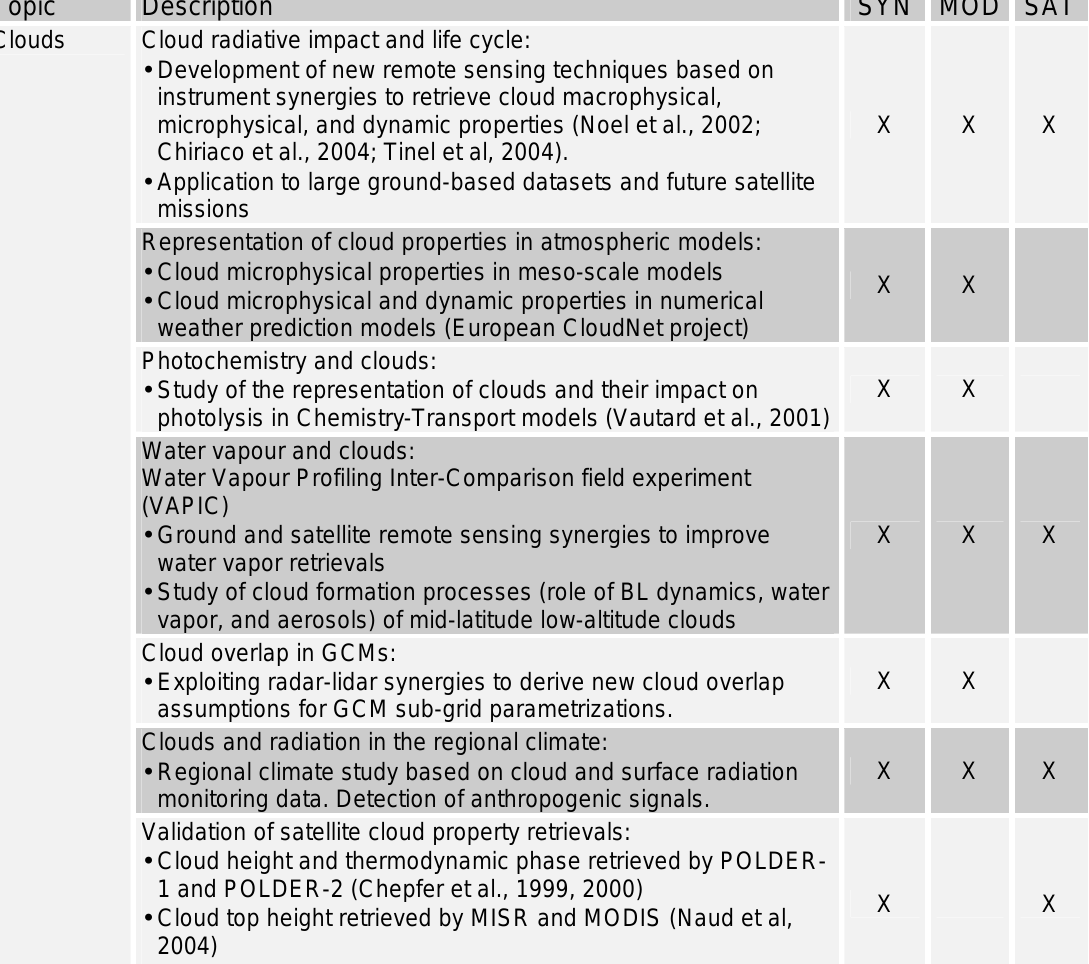
Table 6. Description of main research activities exploiting SIRTA data. “SYN” identifies studies that include developing methods in instrument synergy; “MOD” labels those involving model-to-observation comparisons; “SAT” indicates studies that require satellite data or that develop techniques that can be used on satellite data for large-scale